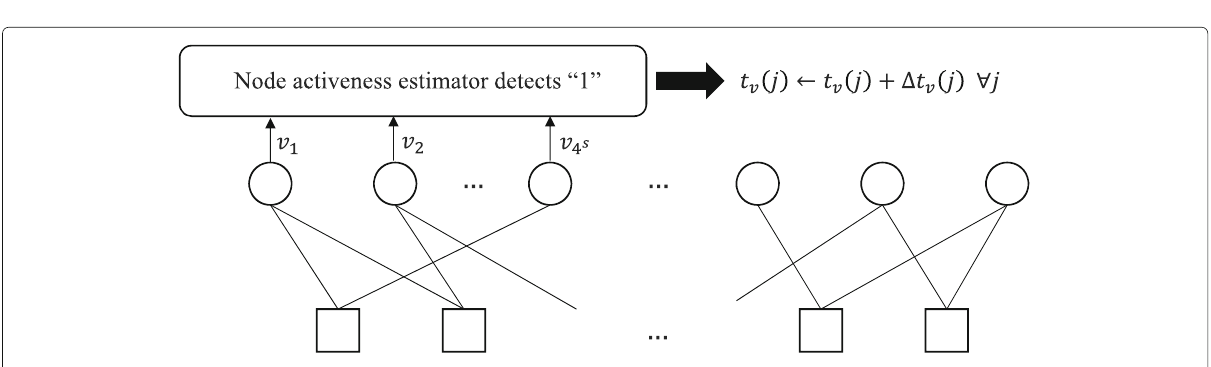
Fig. 3 Increasing threshold t v when the node activeness estimator detects